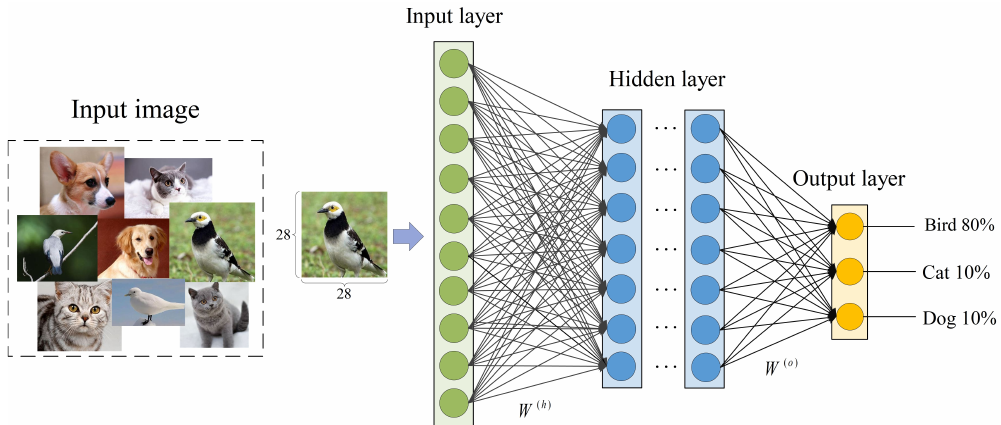
Figure 1. Image recognition by ANN